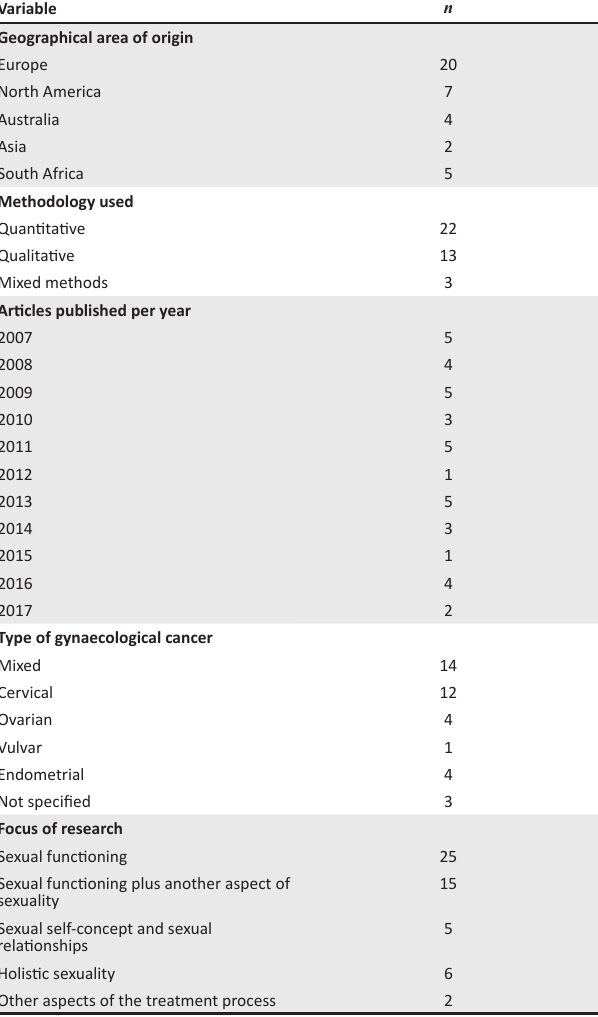
TABLE 2: Summary of results.